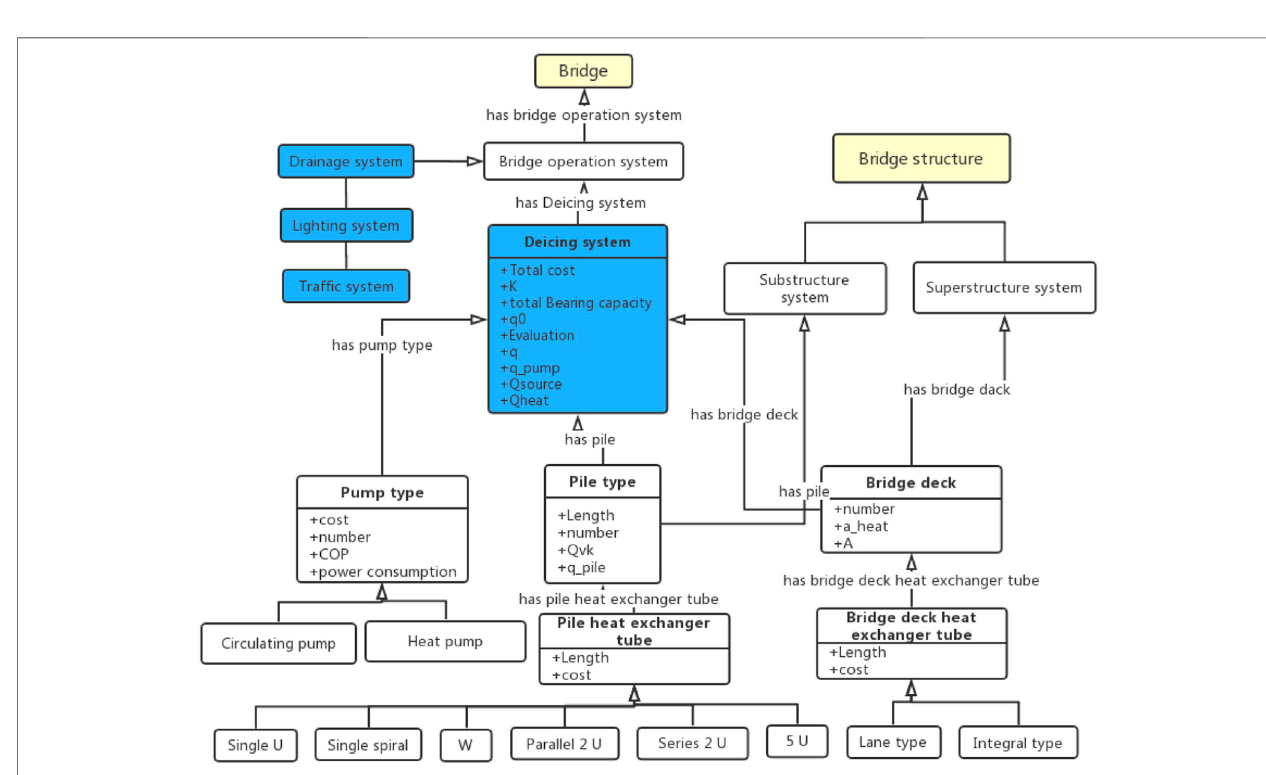
FIGURE 4 | Flowchart of UML classes for the key concepts of OntoBDDS ontology.